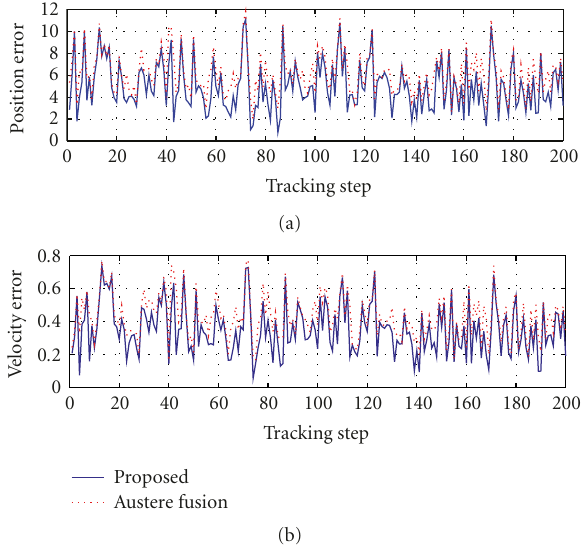
Figure 3: Comparison of the position and velocity errors between proposed method and Austere fusion